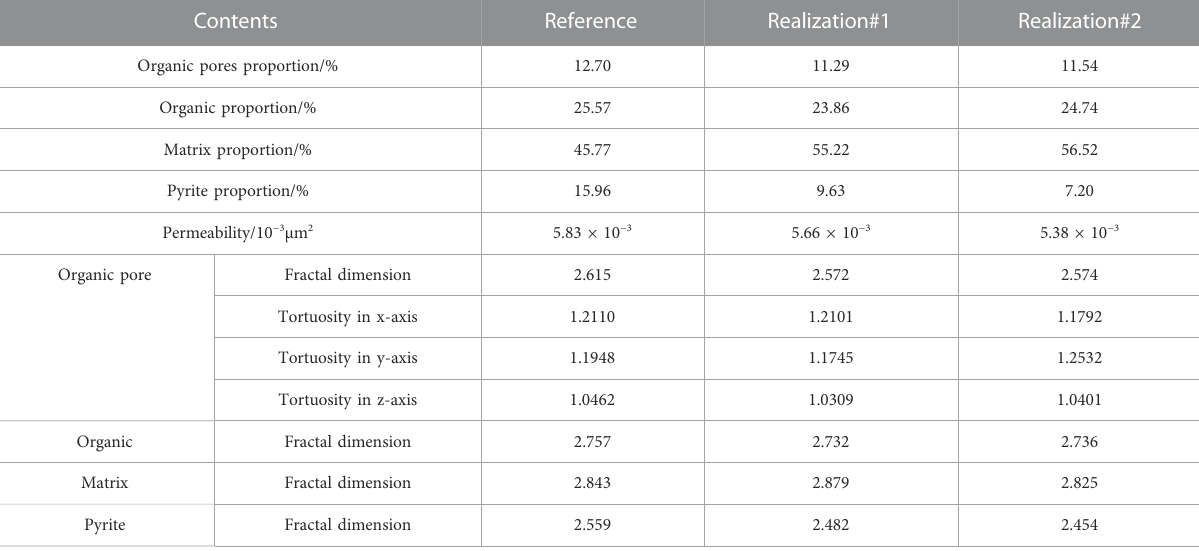
TABLE 2 Petrophysical properties and pore structure parameters of the reference image and two realizations obtained from the proposed approach.